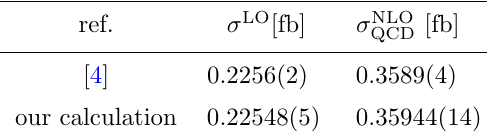
Table 1. Comparison of LO and NLO QCD cross sections, (cid:27) LO and (cid:27) NLO e (cid:0) (cid:22) (cid:23) e (cid:22) + (cid:23) (cid:22) (cid:28) + (cid:23) (cid:28) + X with parameters as given by ref. [4] and a Higgs mass of 120 GeV. In contrast to ref. [4], which uses a modi(cid:12)ed complex-mass scheme with a real mixing angle (cid:18) W , we employ the usual complex-mass scheme where the weak mixing angle is a complex quantity (see eq. (3.18)). Monte Carlo integration errors are indicated in parentheses after each